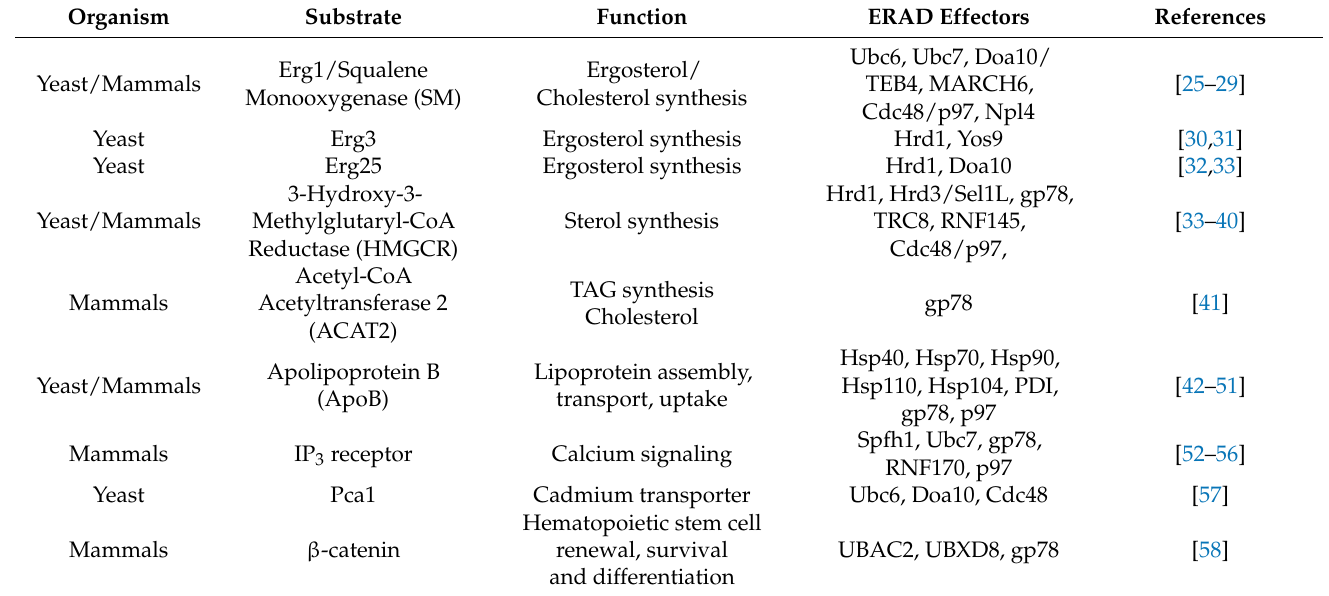
Table 1. Select examples of natively folded ERAD